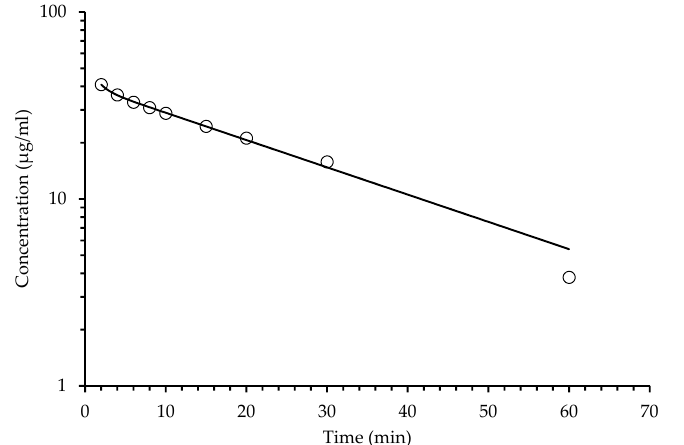
Figure 5. Analysis of variation of the sphaeralcic acid concentrations in plasma with respect to the time in minutes, after intravenous administration (400 mg/kg) of the SaTSS standardized fraction.